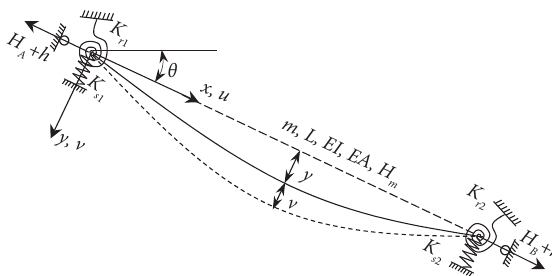
Figure 4: Schematic of a cable under the boundary of elastic embedding and elastic